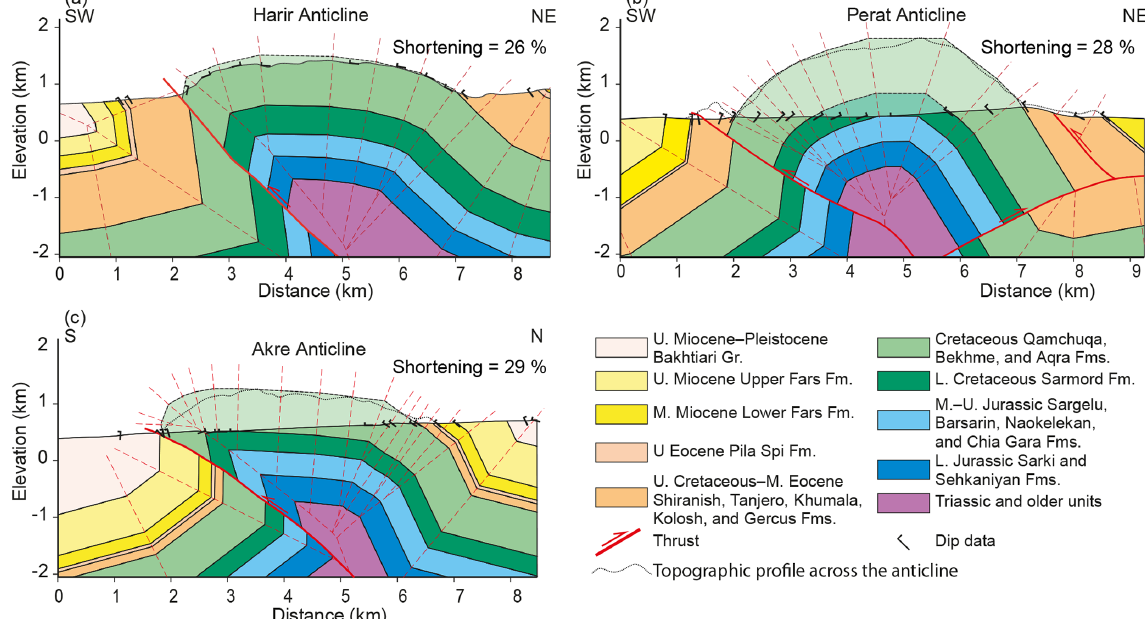
Figure 10. Structural cross sections across the three studied anticlines; (a) Harir section (modified after Syan, 2014), (b) Perat section constructed from field data and thrusts inferred from a seismic line by Csontos et al. (2012), and (c) Akre section constructed from field data (see Figs. 2 and 4 for the locations). In Akre and Perat anticlines the data were collected along gorges and the topographic profile across the anticline along an adjacent transect to the gorges are delineated by a dotted line. The shortening percentage since Late Miocene is shown on each cross